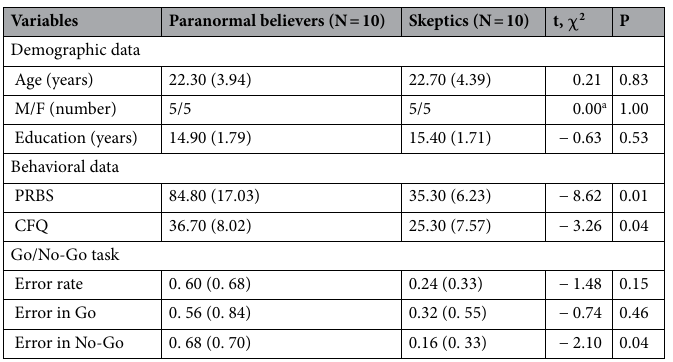
Table 1. Demographic and behavioral characteristics of the participants (Independent sample t-test was used). Data are given as mean (SD). RPBS The Revised Paranormal Belief Scale, CFQ The Cognitive Failures Questionnaire. a Chi-square test was used.